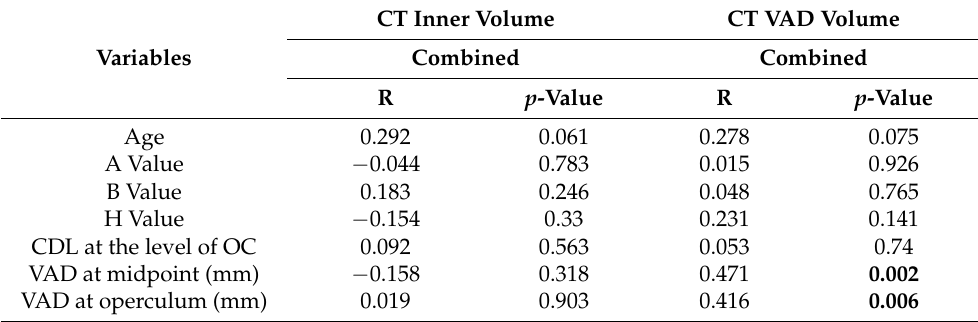
Table 1. Correlation of different variables with CT inner and VAD volumes.